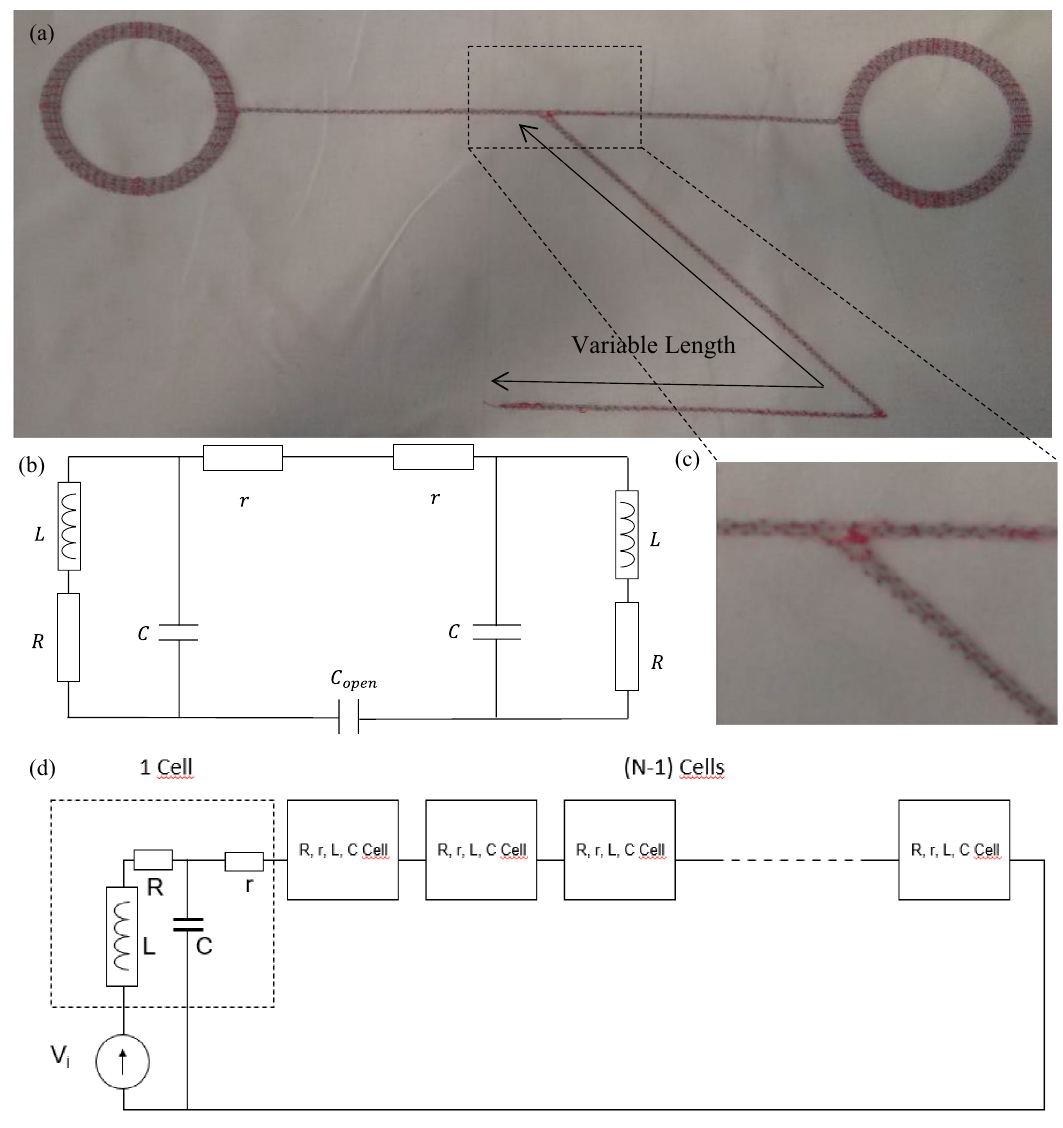
Figure 2. ( a ) The two antennas textile dual-band (NFC-A4WP) combiner, ( b ) its electric diagram and ( c ) a zoom on the opening capacity Copen. ( d ) Case of an N-coils combiner (cells) inductively excited (inductive voltage